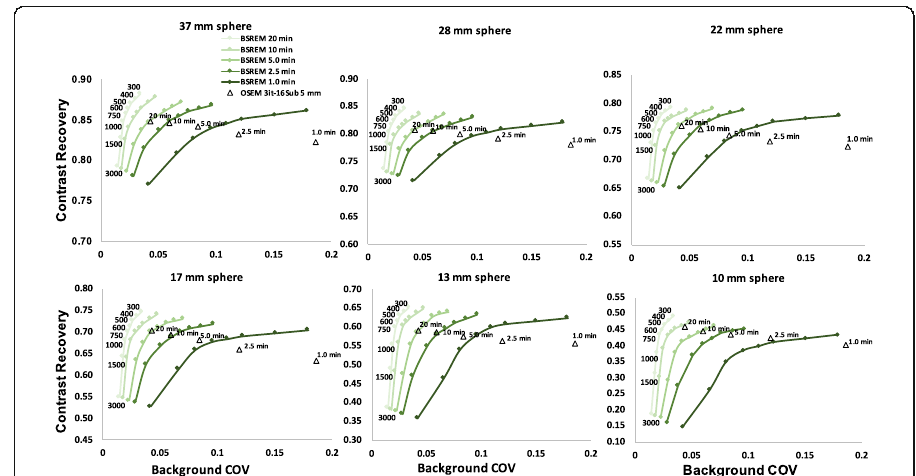
Fig. 1 Contrast recovery of BSREM ( β = 300 – 3000, including TOF and PSF) and TOF-OSEM (3 iterations, 16 subsets, post-filter 5.0 mm and PSF) as a function of the background coefficient of variation for different acquisition times (20, 10, 5.0, 2.5, and 1.0 min) and contrast ratio of 8:1. Different plots are shown with